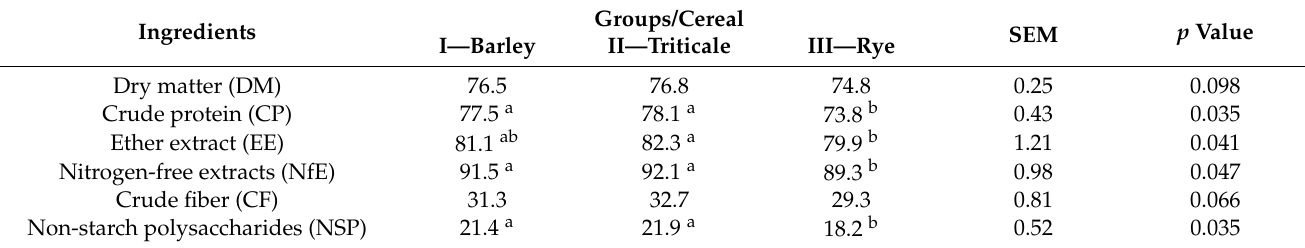
Table 4. Apparent ileal digestibility coefficients (%) of nutrients in fattened pigs.